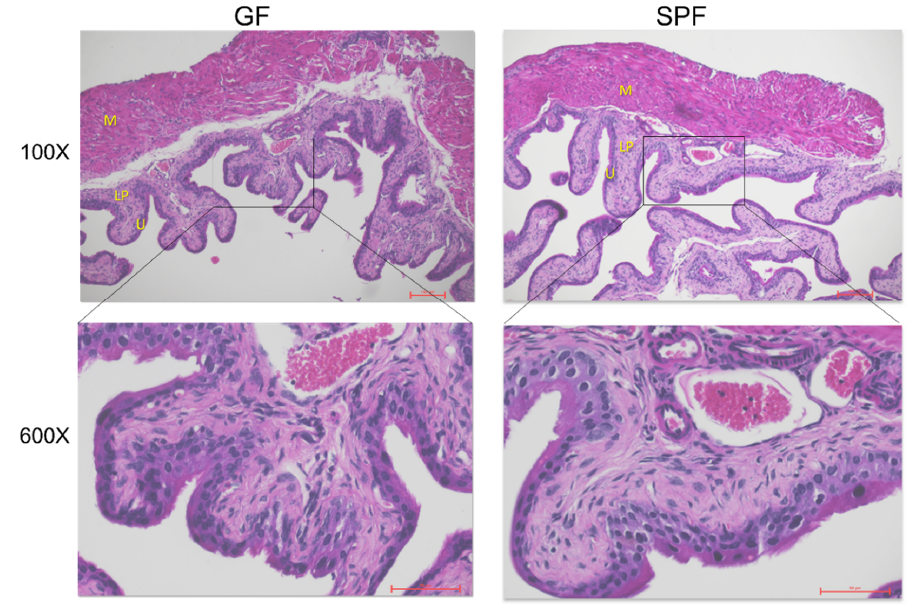
Figure 2. Bladder tissue of GF and SPF animals. Hematoxylin-eosin staining of GF and SPF mice at 100× and 600× magnification. Letters represent particular bladder layers: U—urothelium,